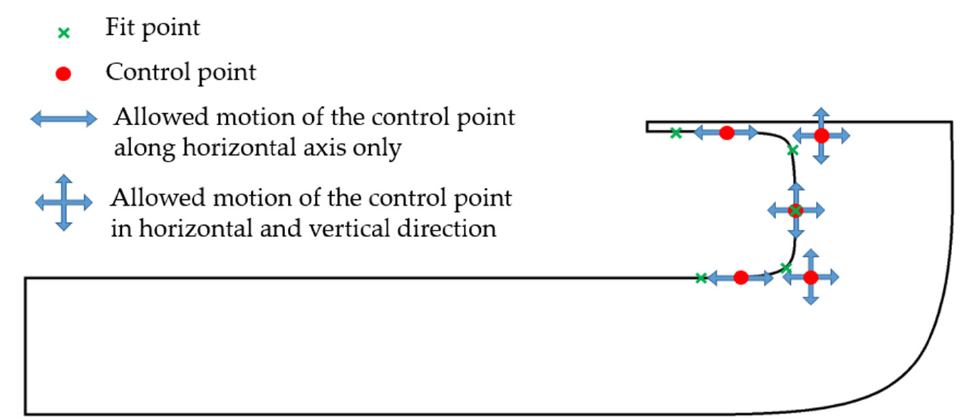
Figure 8. Geometry controls for the 2D optimization case.